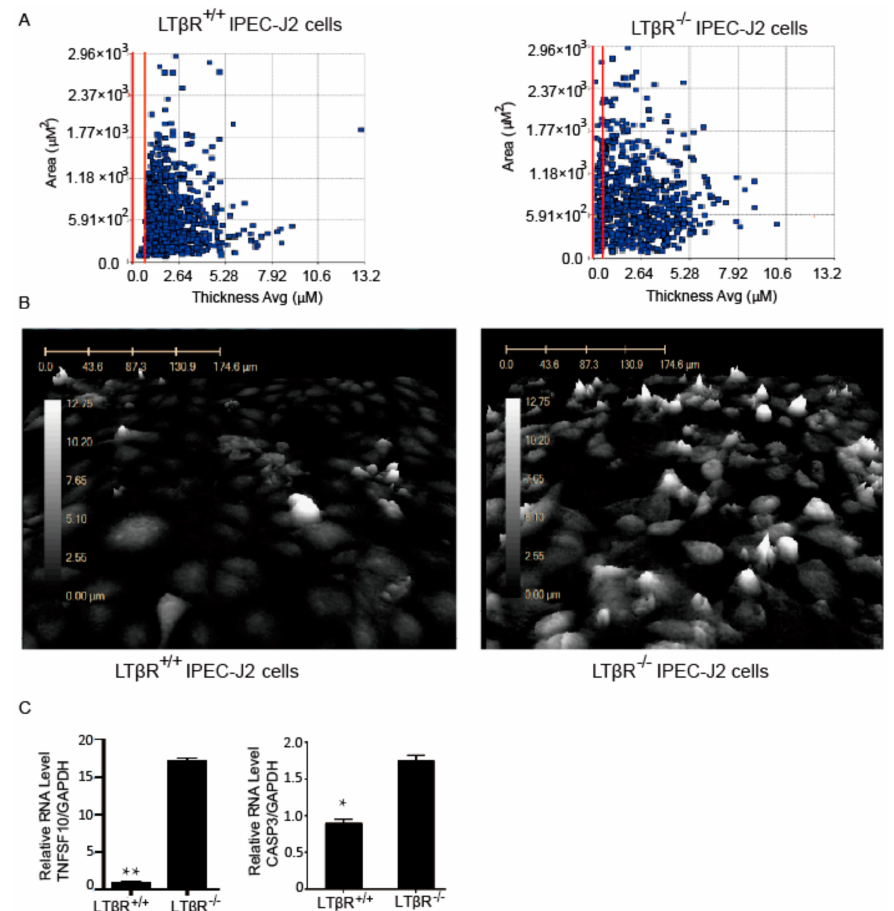
Figure 4. The effect of LT β R on IPEC-J2 apoptosis. LT β R +/+ and LT β R − / − cells were seeded into 6-well plates, and apoptosis was monitored for 72 h by HoloMonitor ®M4 microscopy. ( A ) Dot plot of LT β R +/+ and LT β R − / − IPEC-J2 cells after 72 h culture. The x-axis is the average thickness ( µ M) of the cells, and the y-axis presents the surface area of the cells ( µ M 2 ). Apoptotic cells with lower thickness and higher surface area are between the red lines. Note there are almost no apoptotic cells between the red lines for the LT β R +/+ group (left), while significantly more apoptotic cells are found in the LT β R − / − cell population (right). ( B ) Three-dimensional structures of living LT β R +/+ (left) and LT β R − / − (right) cells after 72 h. The number of tall cells is noticeably increased in LT β R − / − cells. ( C ) Real-time PCR data of TNF superfamily member 10 (TNFSF10) and Caspase 3 (CASP3) in LT β R +/+ and LT β R − / − cells, * p < 0.05 and ** p <